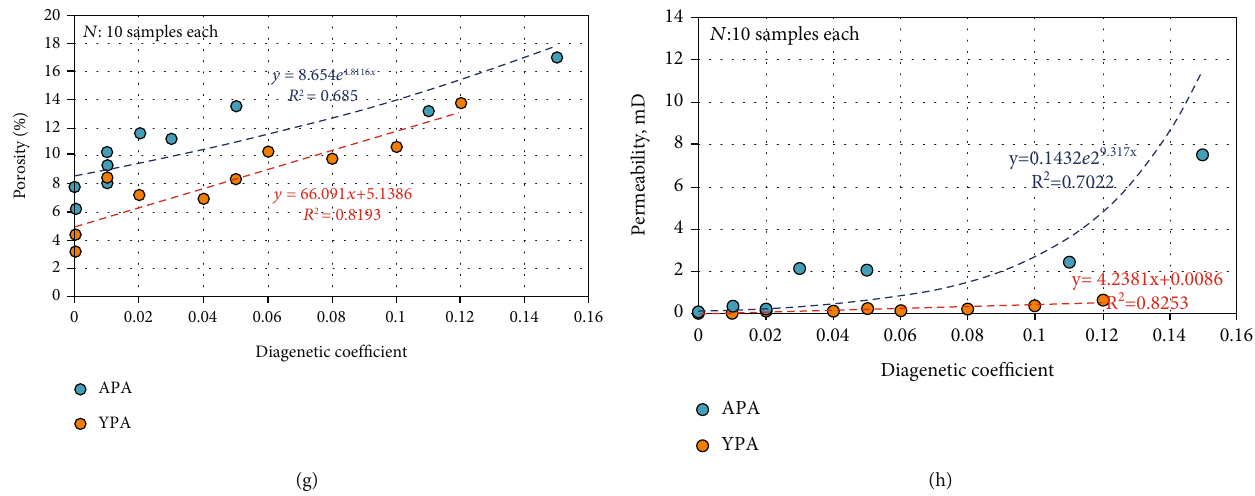
Figure 13: Correlation between diagenetic densi fi cation parameters and the physical properties of the YPA and APA Chang 8 (a) Correlation between the visual compaction rate and porosity; (b) correlation between the visual compaction rate and permeability; (c) correlation between the visual cementation rate and porosity; (d) correlation between the visual cementation rate and permeability; (e) correlation between the visual dissolution rate and porosity; (f) correlation between the visual dissolution rate and permeability; (g) correlation between the diagenetic coe ffi cient and porosity; and (h) correlation between the diagenetic coe ffi cient and